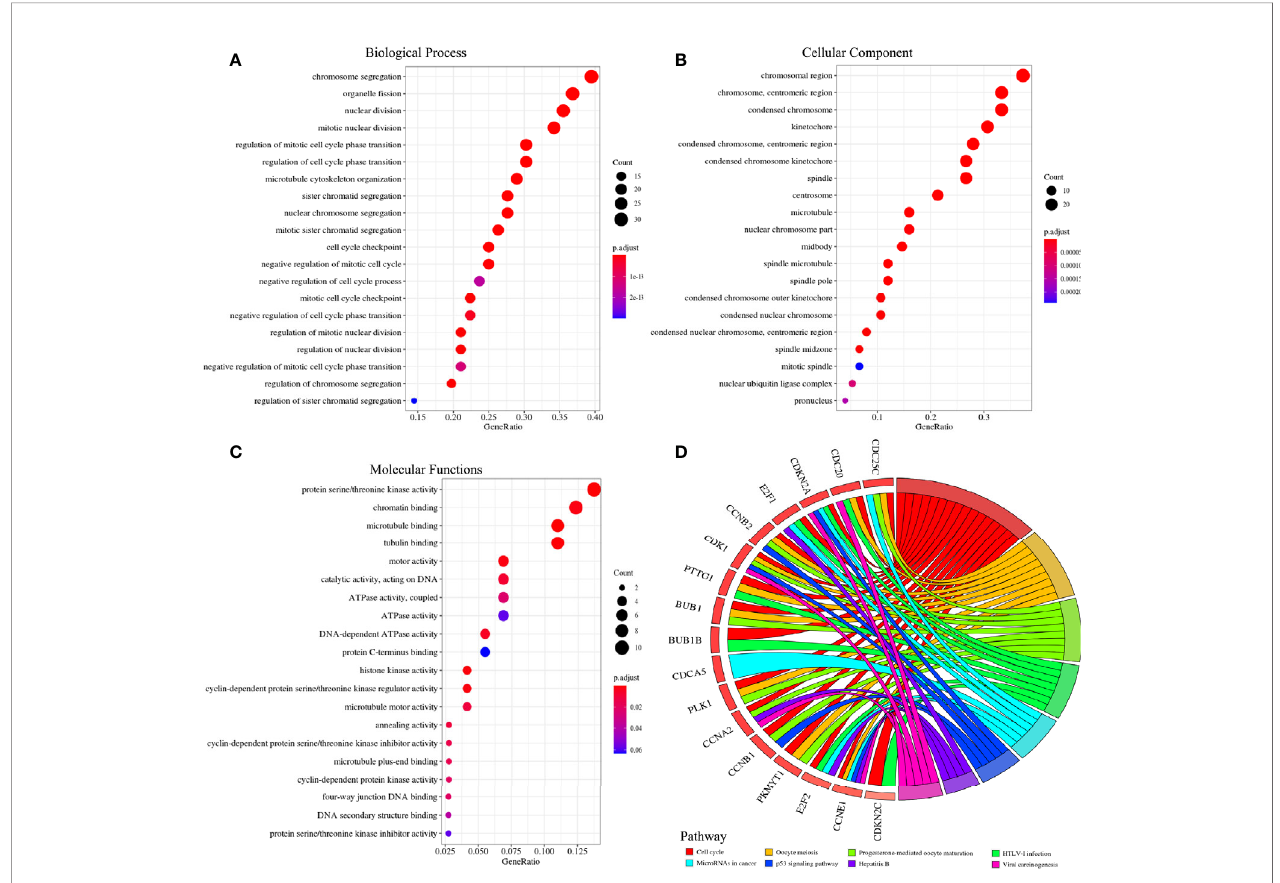
FIGURE 6 | Go and KEGG analysis of 71 co-expressed and co-methylated genes. (A) Terms for biological process. (B) Terms for cellular component. (C) Terms for molecular functions. (D) Pathways for KEGG